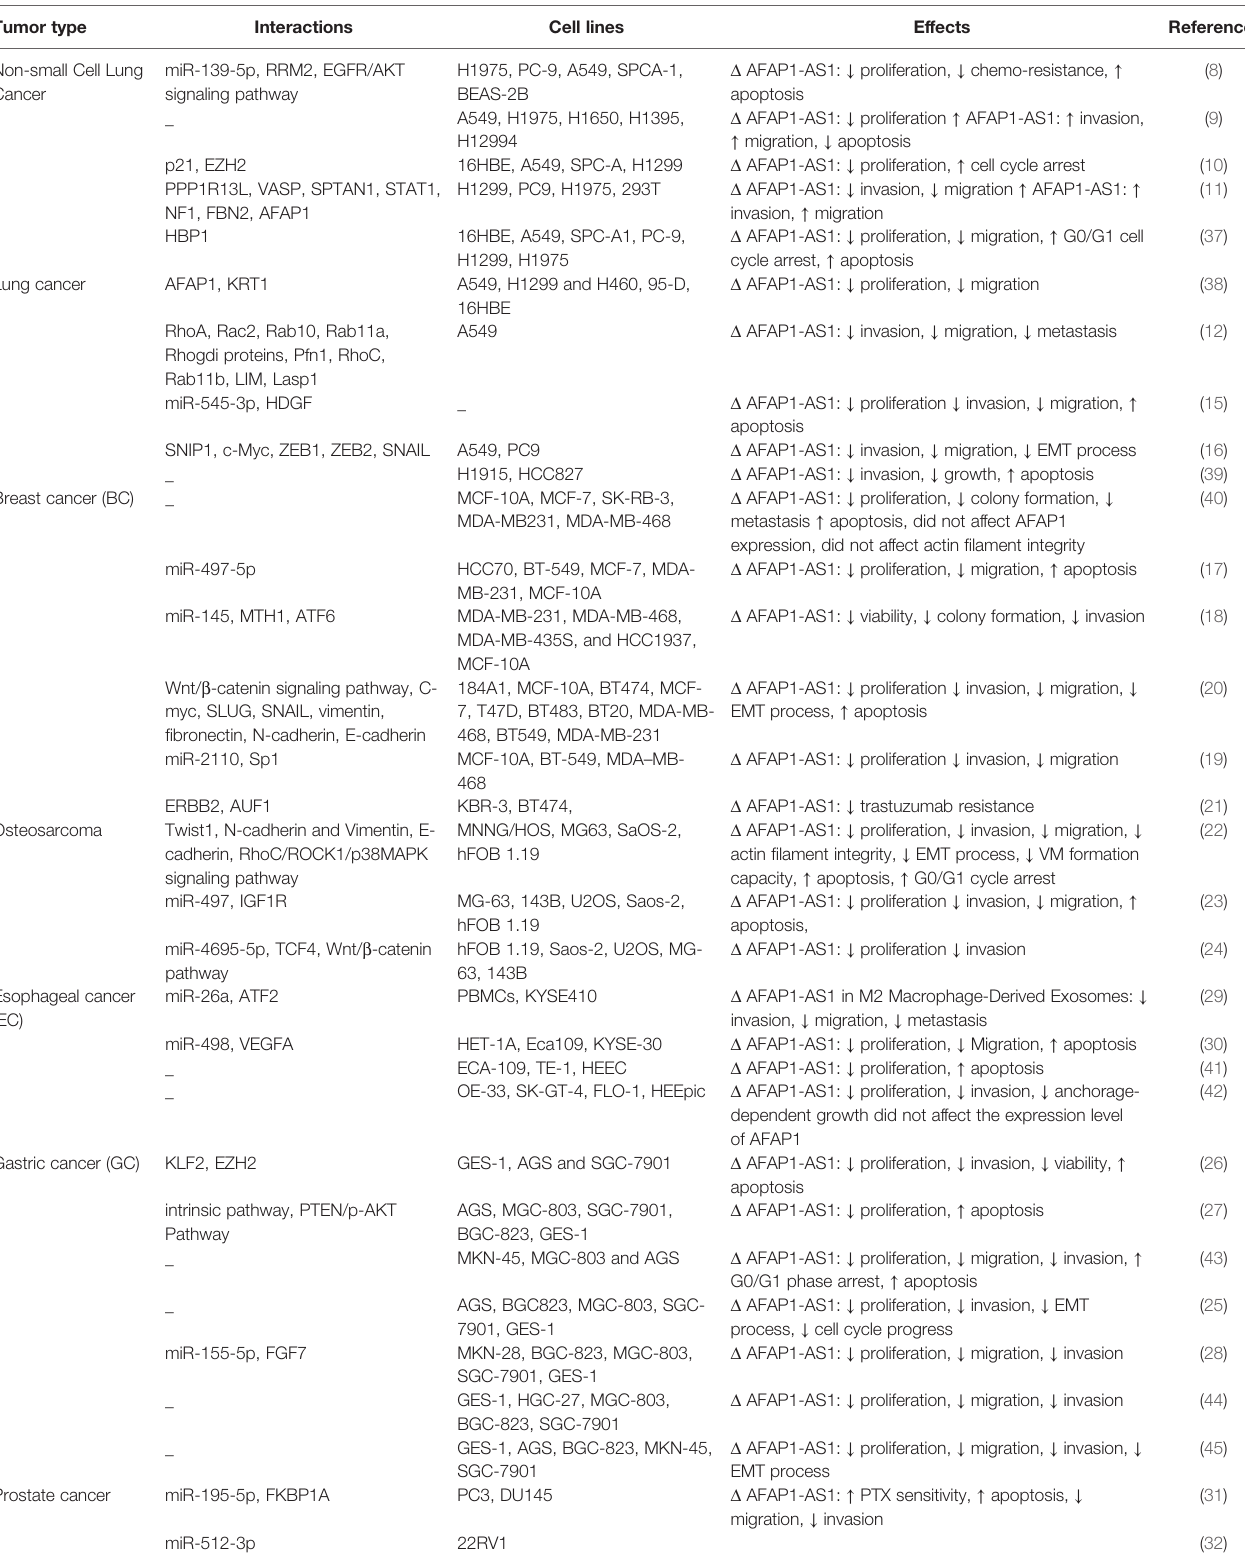
TABLE 1 | Outlines of papers which judged expression of AFAP1-AS1 in cell